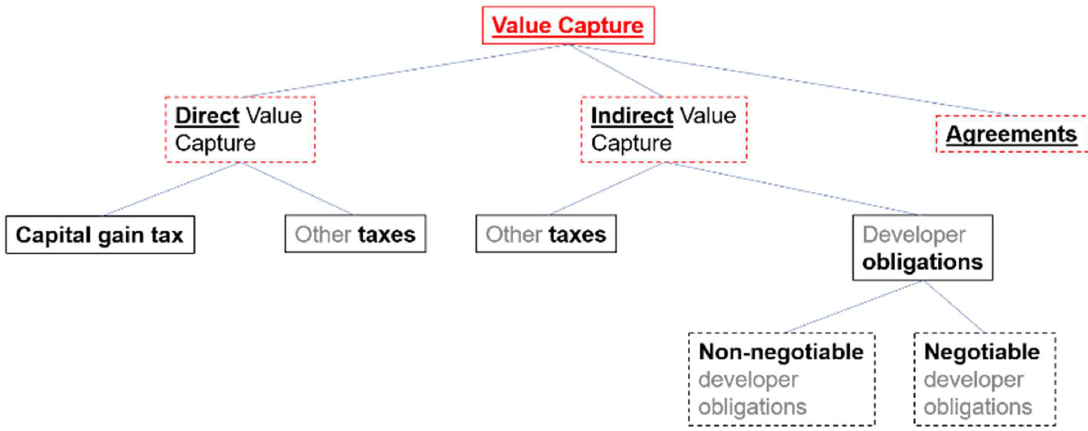
Figure 2. Main PVC tools in agreement with Alterman’s